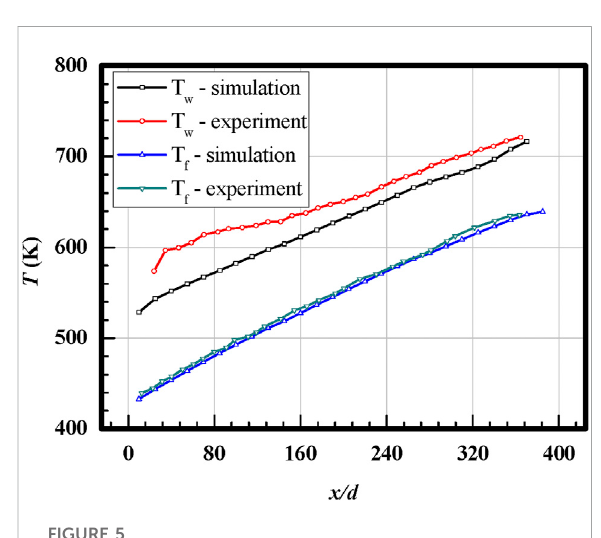
FIGURE 5 Comparison of the fl uid and wall temperature, respectively, fromtheexperimentalresultsandpredictedbythe k – ω